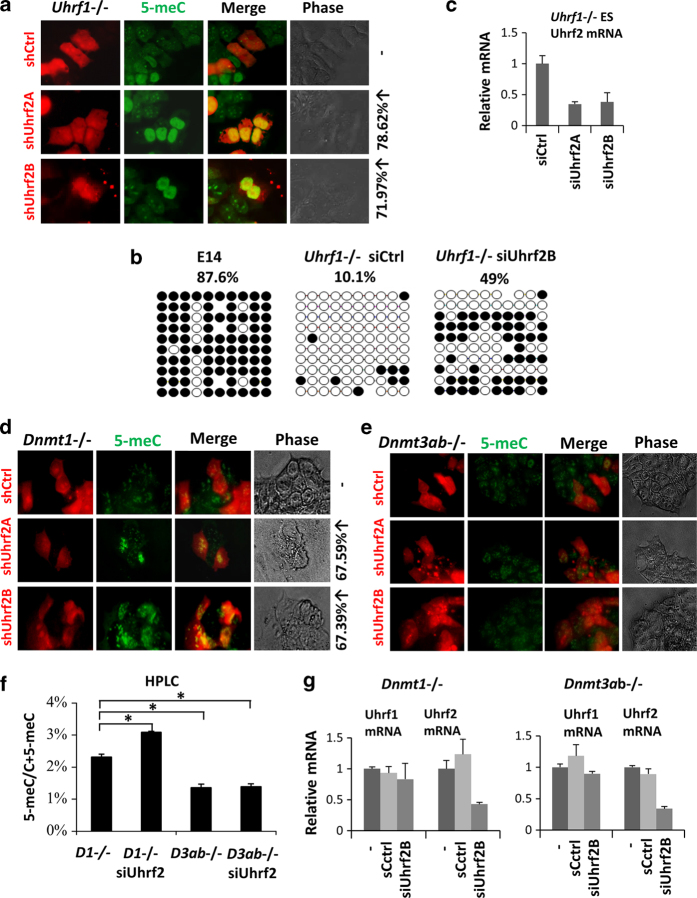
UHRF2 inhibits DNA methylation through negative regulation of de novo DNA methylation. (a) Immunostaining analysis of 5-meC for Uhrf1−/− ES cells treated with control shRNA or shRNAs against Uhrf2. (b) Bisulfite sequencing analysis of DNA methylation in IAP repetitive sequences from control E14 and Uhrf1−/− ES cells treated with control siRNA or siUhrf2B. (c) qRT-PCR analysis showing efficient downregulation of Uhrf2 mRNA upon treatment of Uhrf1−/− ES cells with two different siUhrf2A and siUhrf2B. Bars and error bars represent mean values and s.e.m. from three measurements, respectively. (d) Immunostaining analysis of 5-meC for Dnmt1−/− ES cells treated with control shRNA or shRNAs against Uhrf2. (e) Immunostaining analysis of 5-meC for Dnmt3ab−/− ES cells treated with control shRNA or shRNAs against Uhrf2. (f) Quantitative measurement of the levels of 5-meC of genomic DNA from Dnmt1−/− ES cells (D1−/−) or Dnmt3ab−/− (D3ab−/−) treated without or with siUhrf2 by HPLC analysis. Asterisk indicates a P-value of <0.05. (g) qRT-PCR analysis showing efficient downregulation of Uhrf2 mRNA upon treatment of Dnmt1−/− ES cells or Dnmt3a/3b−/− ES cells with siUhrf2B. Bars and error bars represent mean values and s.e.m. from three measurements, respectively.